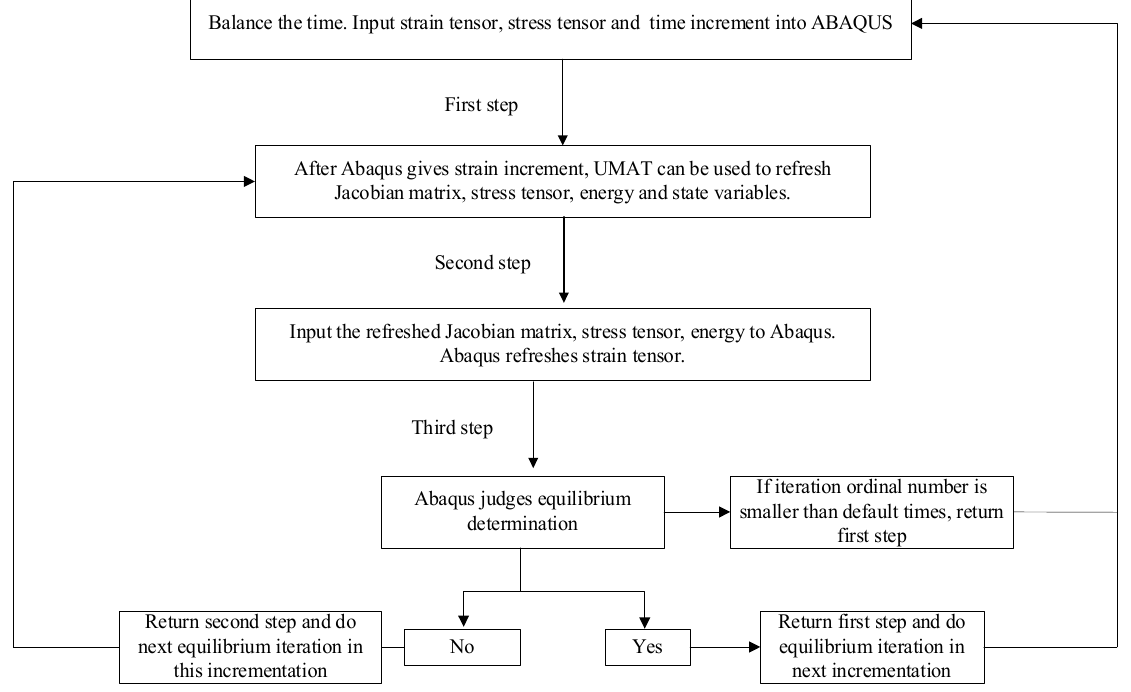
Figure 2. ABAQUS calls UMAT subroutine .